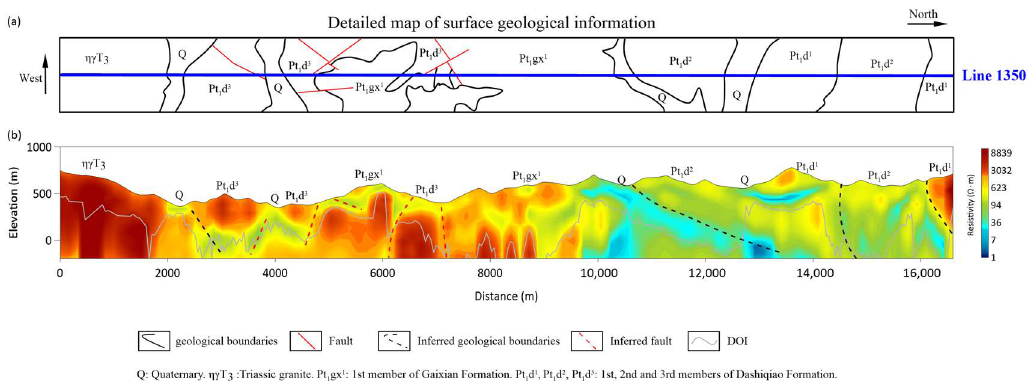
Figure 8. The detailed geological information near the line 1350 and the inversion profile result. ( a ) The detailed geological map near line 1350. The blue line represents the position of line 1350. ( b ) Resistivity section of line 1350.